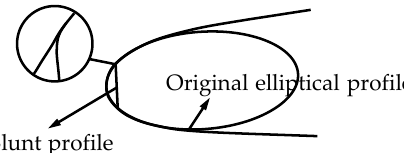
B l u n t p r o f il e Figure 11. Erosion blade modeling of the elliptical leading edge. Reproduced from [63]. When the incidence angle is positive, the airflow separation is more drastic for eroded blades than the original blades, and the extreme curvature of the blunt leading edge causes pressure spikes [74] which accelerates the boundary layer separation and transitions. At the design point, the leading edge separation of the original blade may be more severe than that of the blunt leading edge [66]. This is because the presence of the zero curvature platform of the blunt leading edge shortens the distance from the stagnation point to the separation point, and the velocity pattern inside the boundary layer of the platform part can be well maintained, which has a certain delayed effect on the separation [75]. With the interaction of pressure spikes and the blunt platform, the eroded leading edge suppresses airflow separation and the transition of the flow at 0° incidence. The effects of the eroded leading edge on the boundary layer are mainly at the suction side of the blade. When significant separation does not occur at the suction side, the eroded leading edge has little influence on the airflow separation. The damage to the leading edge changes the static pressure distribution on the surface of the blades [51]. For subsonic airfoils, it is mainly reflected in the front 15% relative chord length regions [63,72], especially in the suction surface, and the difference grows with the increase of the incidence. Figure 12 shows the static pressure coefficient distribution on the suction side with an incidence angle ranging from 0° to 7°. The separation position of the original blade tends to be stable after the incidence increases to a certain degree, but the degraded blade forms severe double suction spikes at large incidences, which cause a strong inverse pressure gradient and poor flow conditions. The separation bubble characteristics are obvious and accelerate the transition of the laminar boundary layer into the turbulent boundary layer, leading to increased friction losses inside the boundary layer.